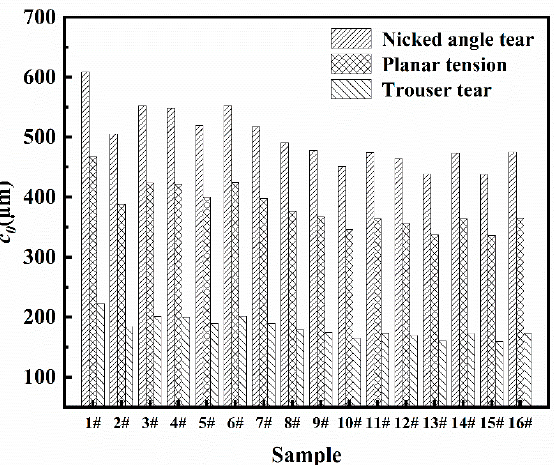
Figure 9. ( a ) Schematic diagram of the distribution of crack precursors on vulcanized rubber sheet ( b ) Stress–strain curves of the five samples under simple tension.